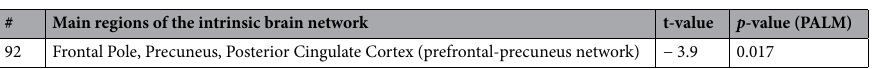
Table 2. Intrinsic brain network that encodes the intensity of CM. The t-value represents the relationship between the fluctuating subjective experience of CM and the time course of component activity (see Fig. 2,